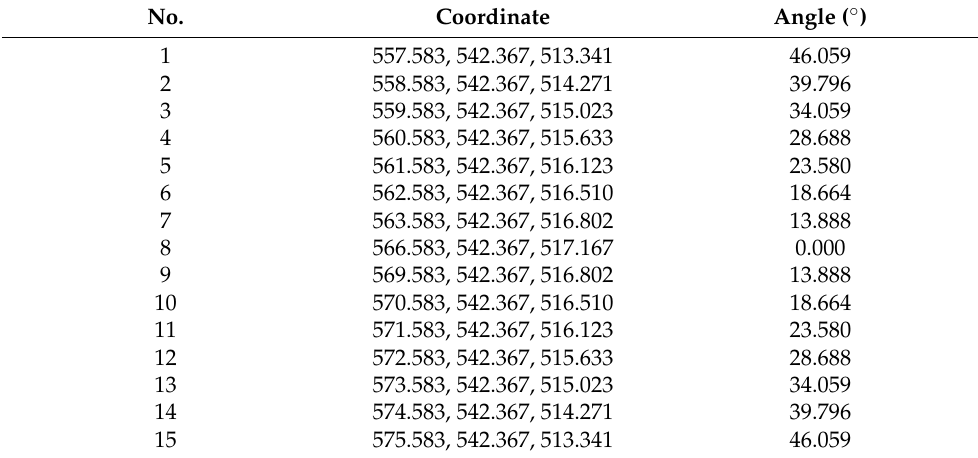
Table 4. The coordinate of the selected measurement points on the calibration ball and the corre- sponding contact angles.